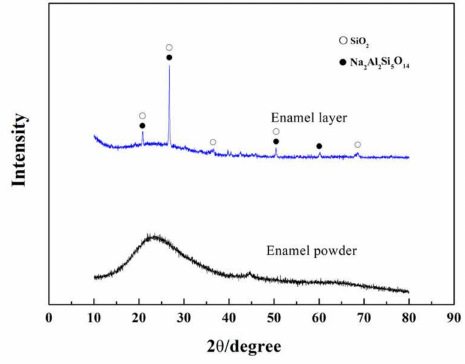
Figure 6. XRD patterns of the enamel powder and enamel